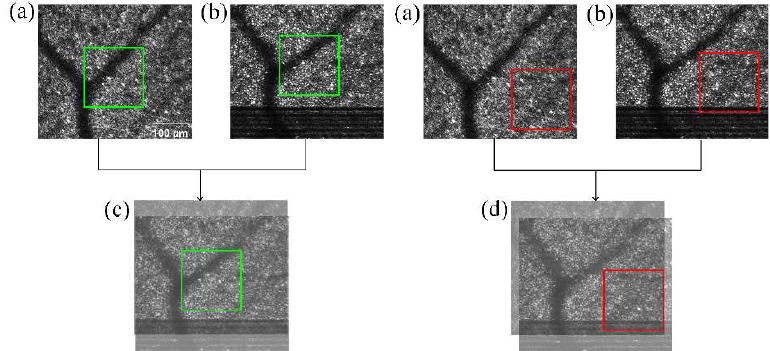
Figure 8. The frame with the largest horizontal displacement difference; ( a ) is the first frame of the sequence; ( b ) shows the frame with the largest difference between UECO and manual registration; ( c ) is the result of UECO; and ( d ) is the result of manual registration. The green and red boxes are the references for the UECO and manual registration, respectively. For display purposes, the transparency in ( c , d ) was set to 50%. The scale bar is 100 µm.